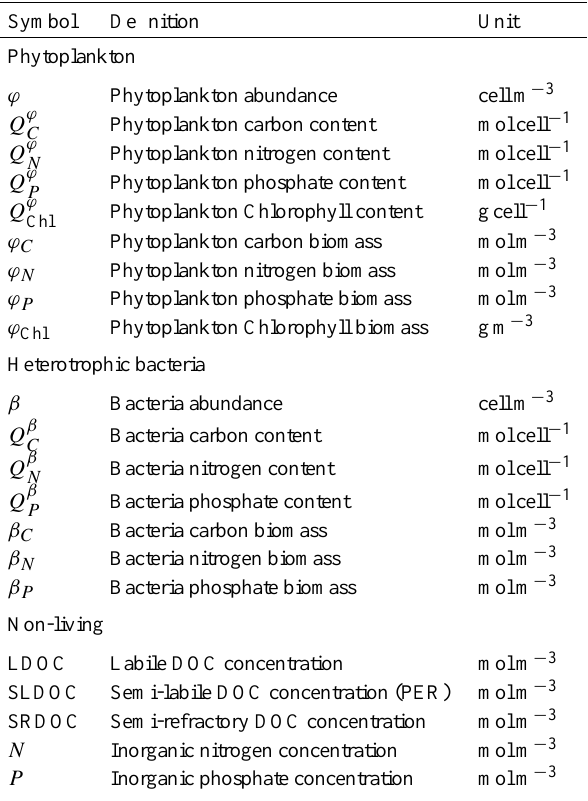
Table 1. Model’s state